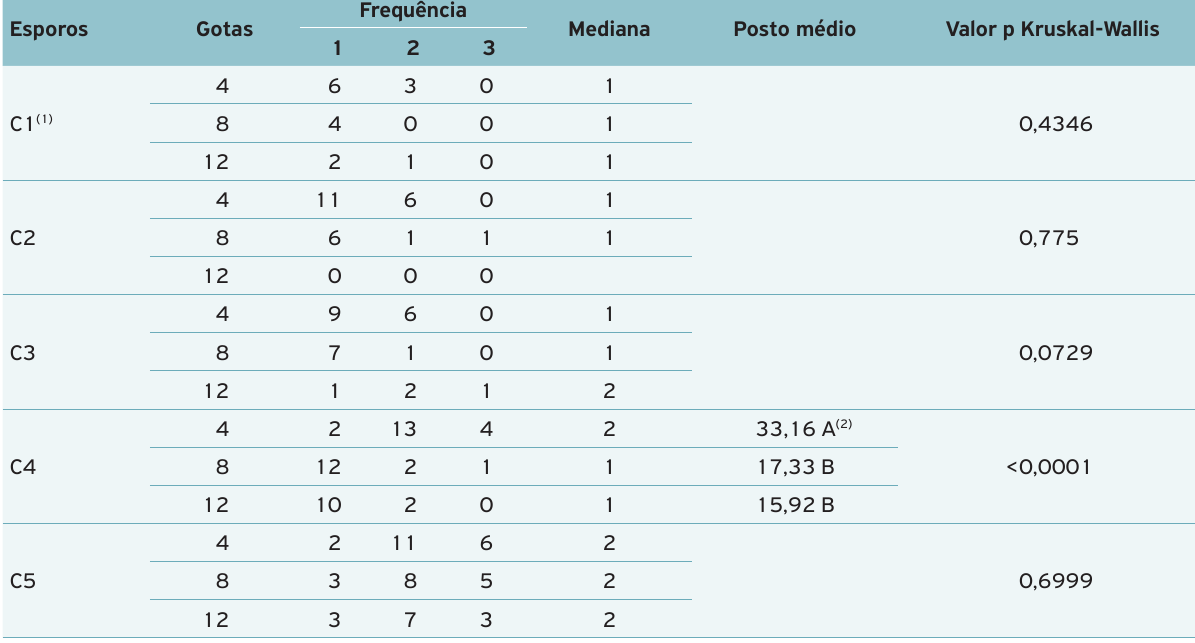
Tabela 5. Comparação entre os postos médios das intensidades de linha de teste dos resultados positivos da quantidade de gotas da solução extratora utilizadas dentro de cada classe de número de